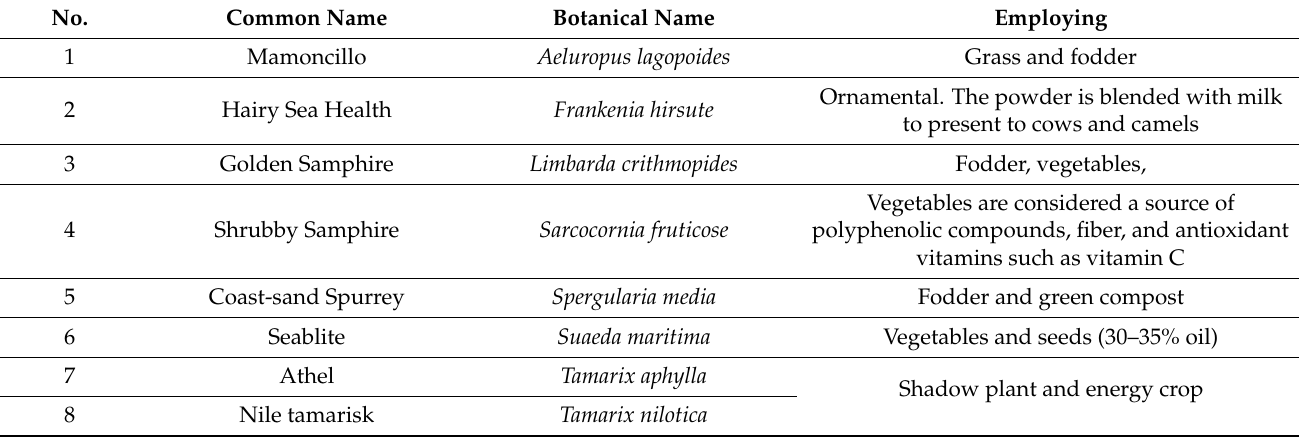
Table 3. Plants grow in high saline conditions